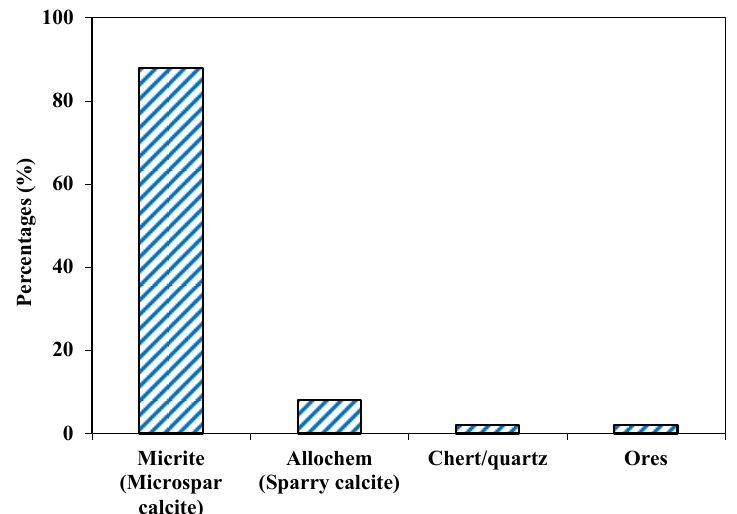
Figure 11. Mineralogical composition of Sada aggregate.